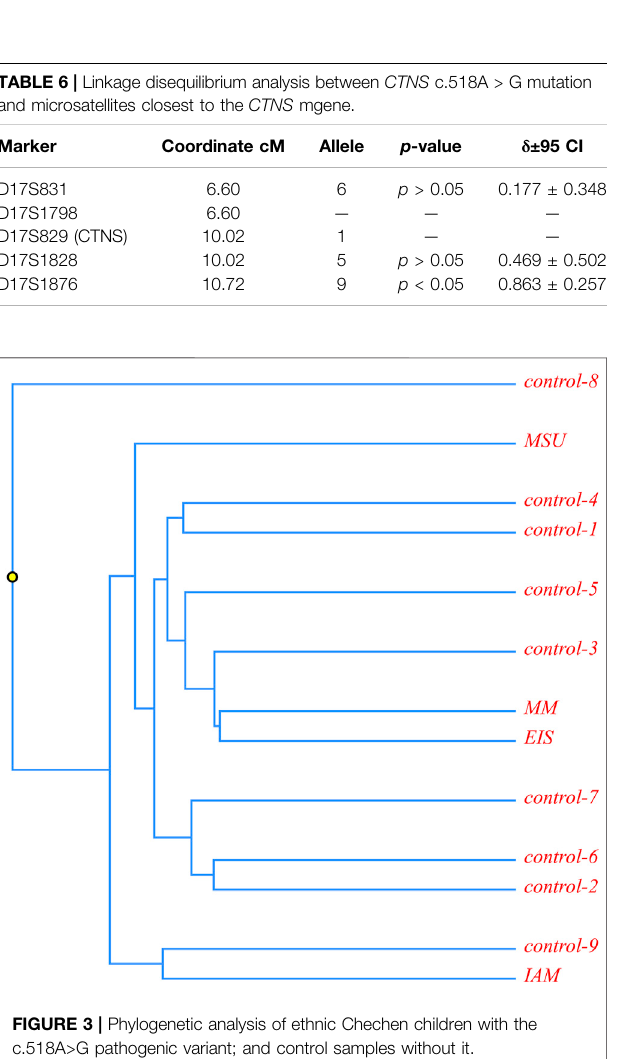
The F-test results for alleles of markers with the highest linkage disequilibrium values ( δ ) are presented in Table 6 .